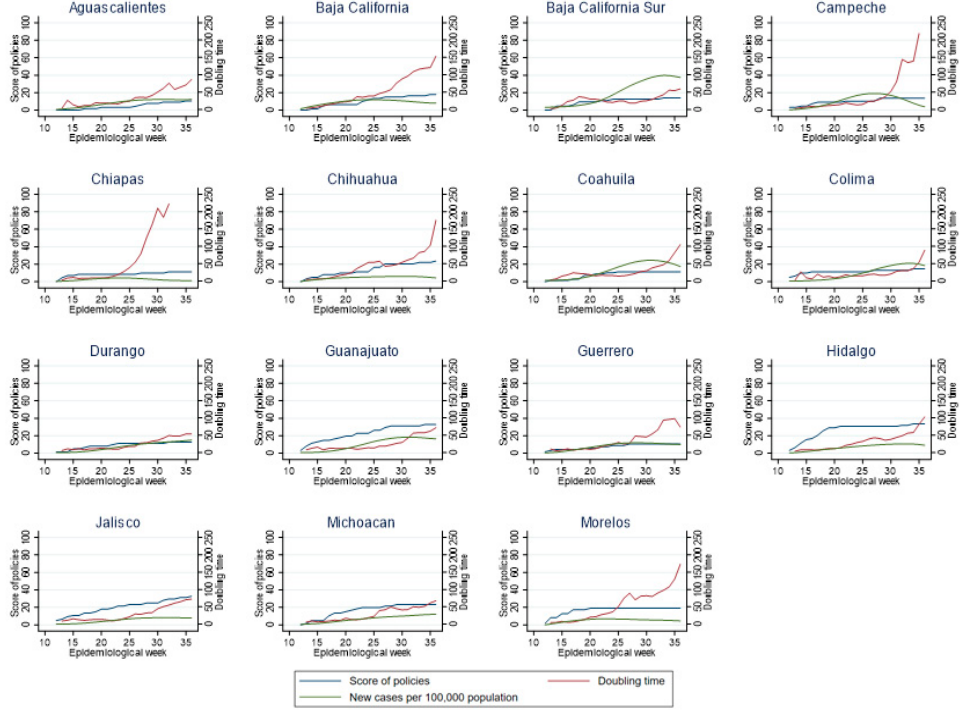
Figure 3. Policy index, new cases, and doubling time by week in states of Mexico (A).